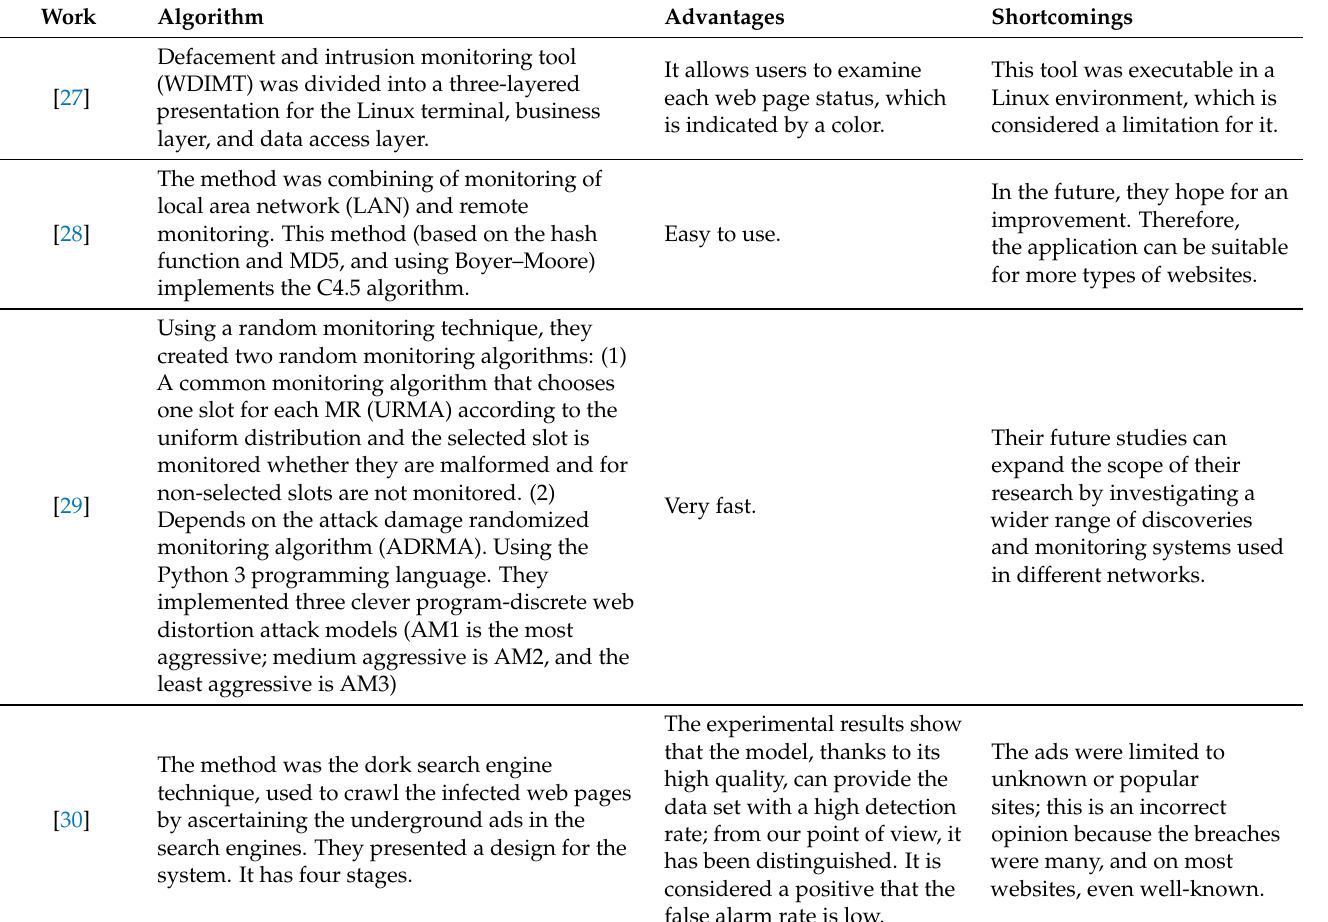
Table 2. Defacement detection is based on another